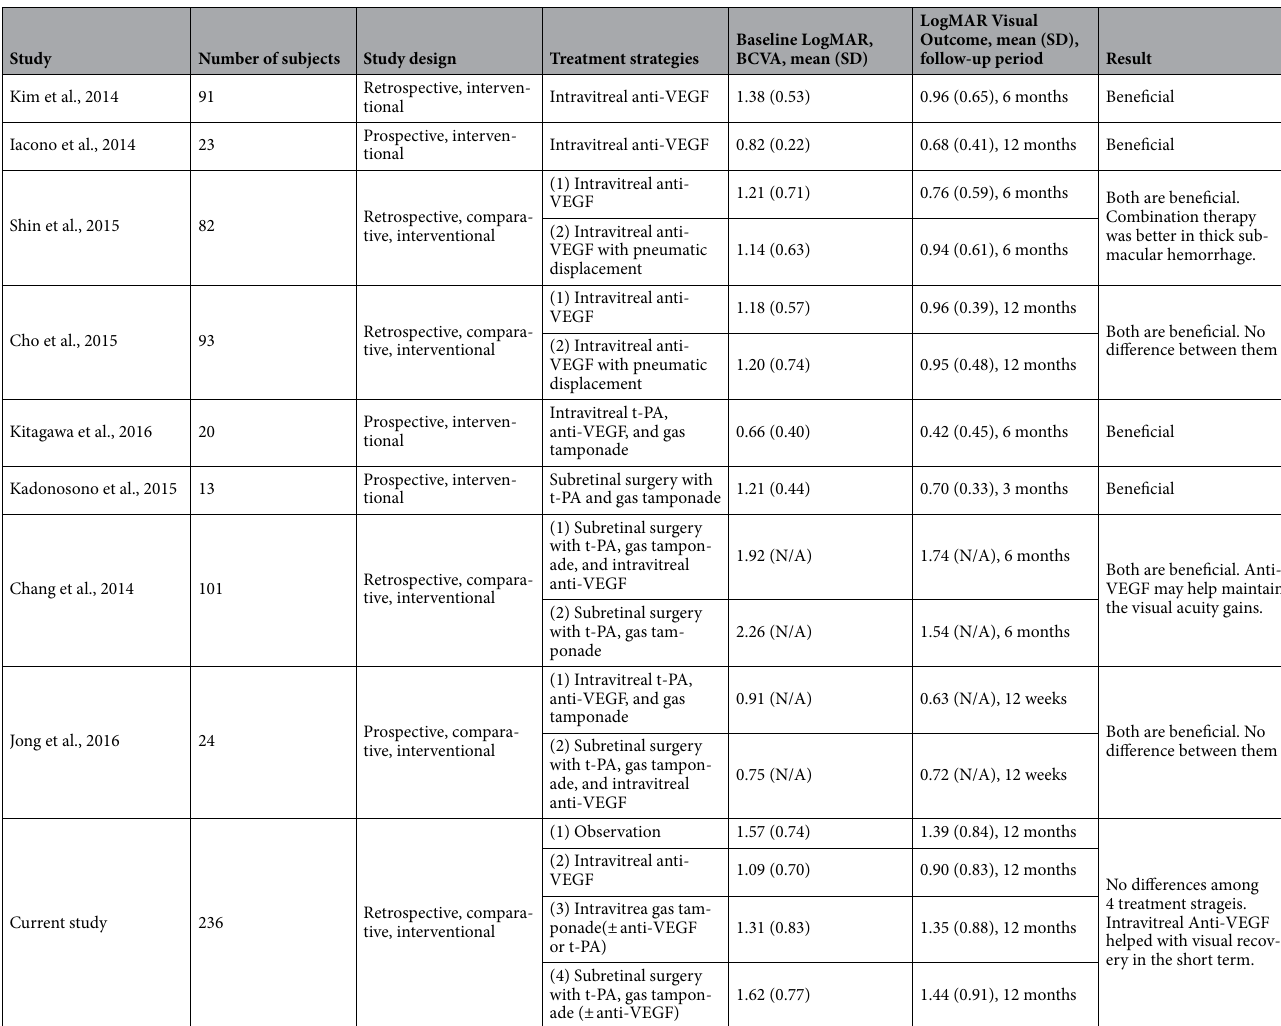
Table 3. Previous studies of various treatment modalities for submacular hemorrhange in neovascular age- related macular degeneration. LogMAR, logarithm of minimum angle resolution; SD, standard